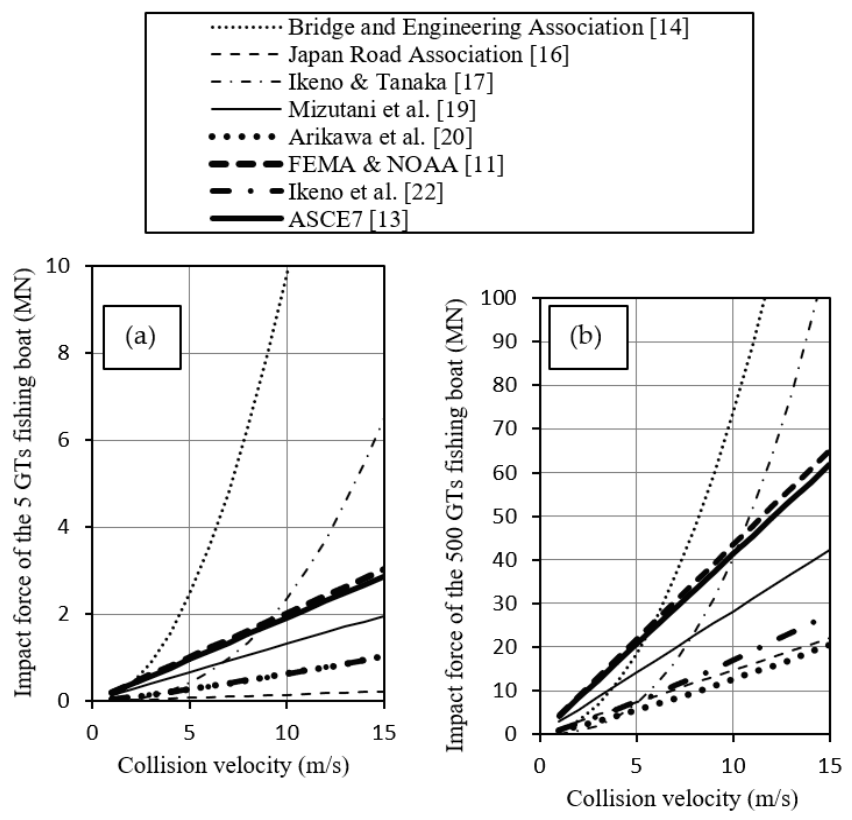
Figure 12. Impact force of the fishing boat: ( a ) the case of the 5 GTs boat, and ( b ) the case of the 500 GTs boat. Table 4. Results of the reliability examination of impact force formulae.